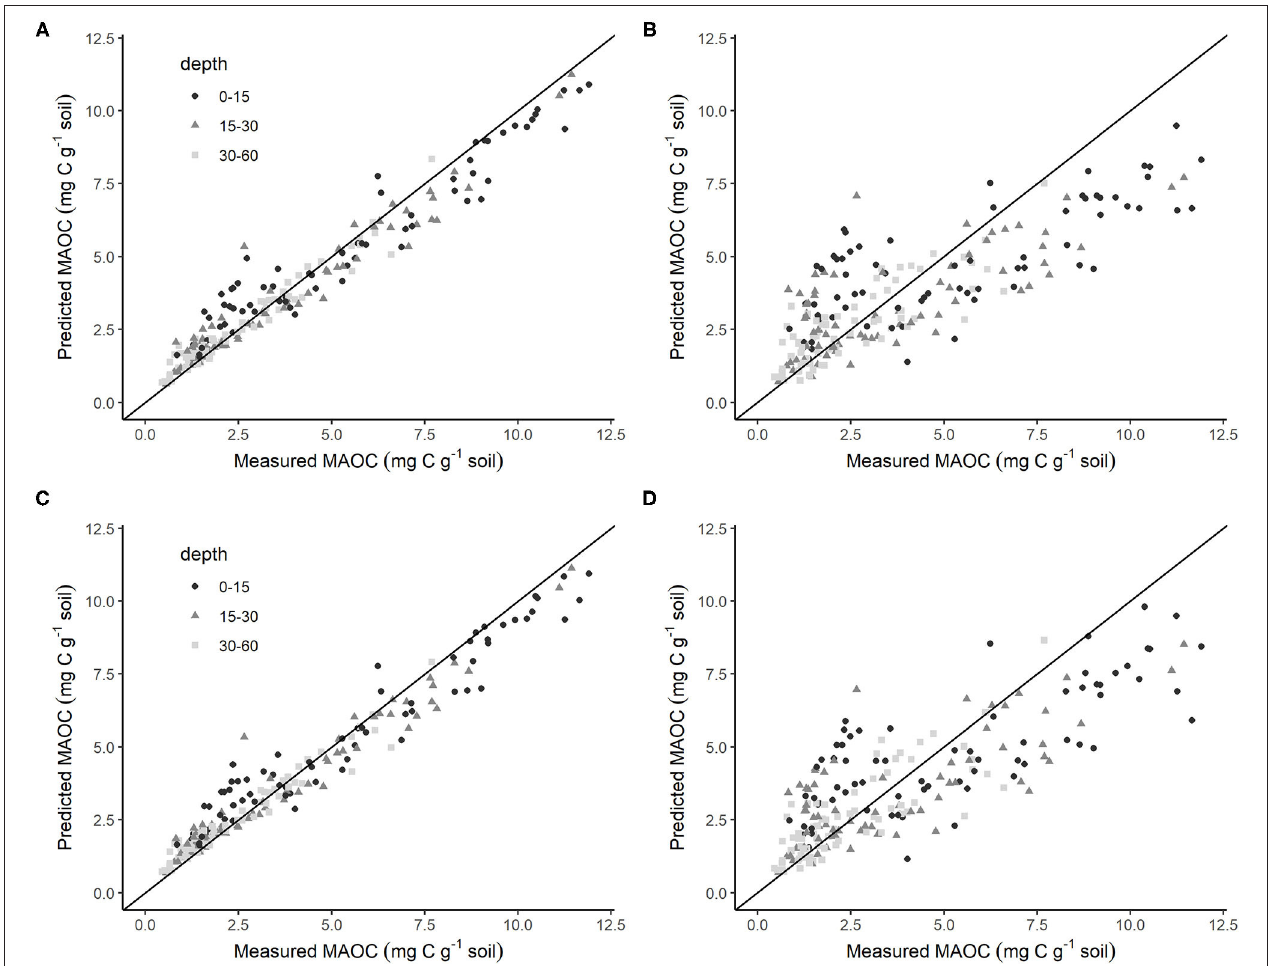
FIGURE 5 | Values of MAOC from predictive models using SSA proxy as the mineral surface area availability metric (A,B) , or texture (%clay and %silt) as the mineral surface area availability metric (C,D) plotted against measured MAOC values (C concentration in the < 50 µ m fraction) on the same 216 samples. (A,C) use Random Forest predictive algorithms ( A R 2 : 0.790; C R 2 : 0.788) while (B,D) are from Stepwise Multiple Regression with AIC algorithms ( B R 2 : 0.713; D R 2 : 0.717). The black line shows a 1:1